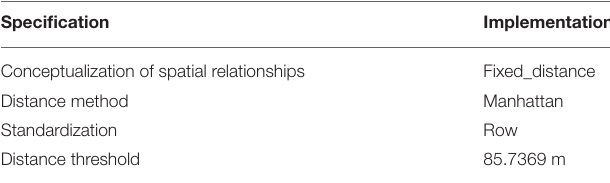
TABLE 3 | Summary of the data processing information for global Moran’s I